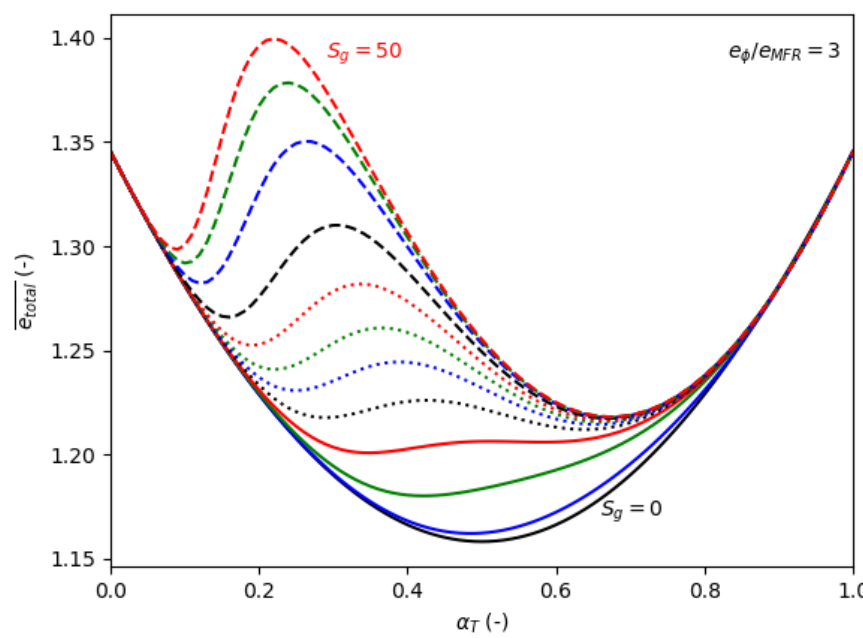
Figure A4. Influence of the geometric swirl number (fuel rich combustion) for S g values in